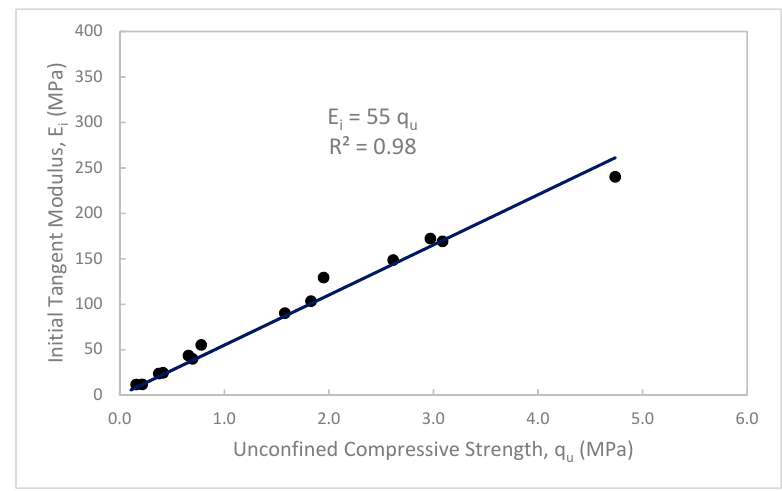
Figure 15. Initial tangent modulus (E i ) vs. unconfined compressive strength (q u ) of the treated waste sand.